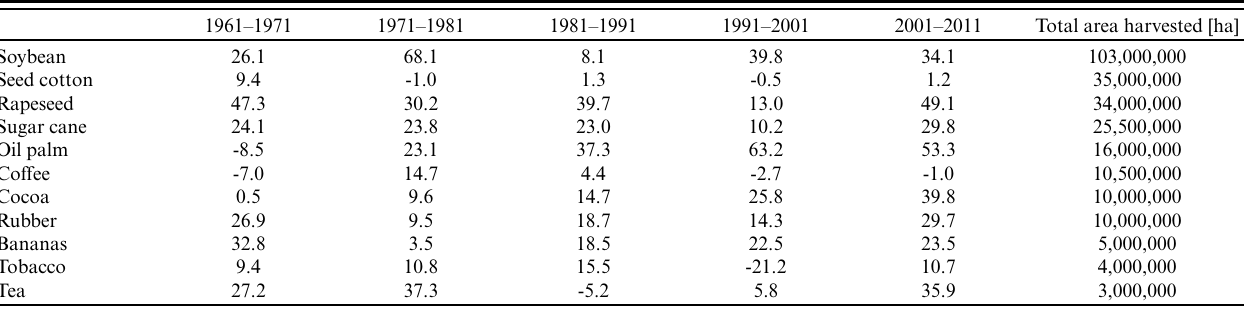
Table 1 . Decadal area expansion for a number of plantation commodities (rates expressed as decadal percentage increase). FAOstat